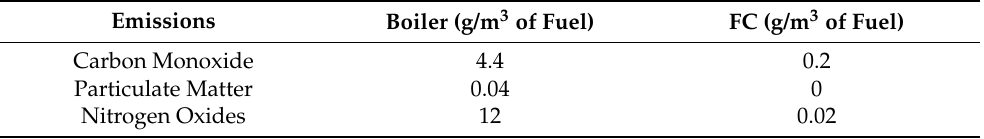
Table 3. Emission productions for NG-based energy